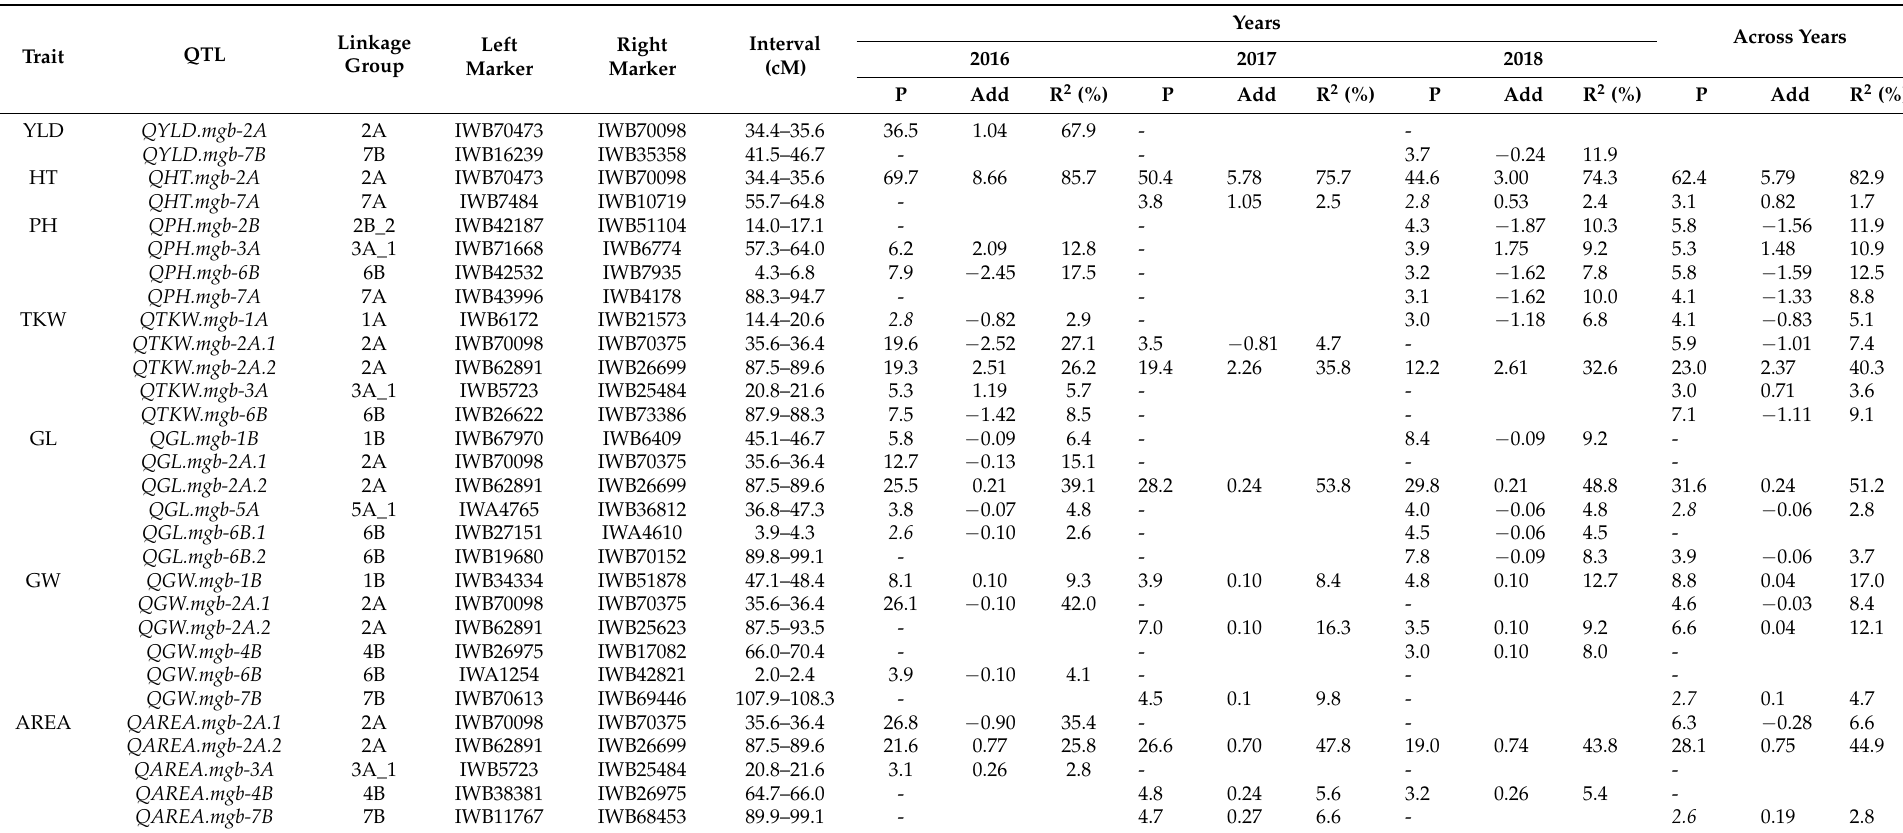
Table 5. Quantitative trait loci (QTL) for grain yield (YLD), plant height (PH), heading time (HT), thousand kernel weight (TKW), grain length (GL), grain width (GW), grain area (AREA) in the Liberdur x Anco Marzio RILs mapping population evaluated at Valenzano (Bari, Italy) for three years.